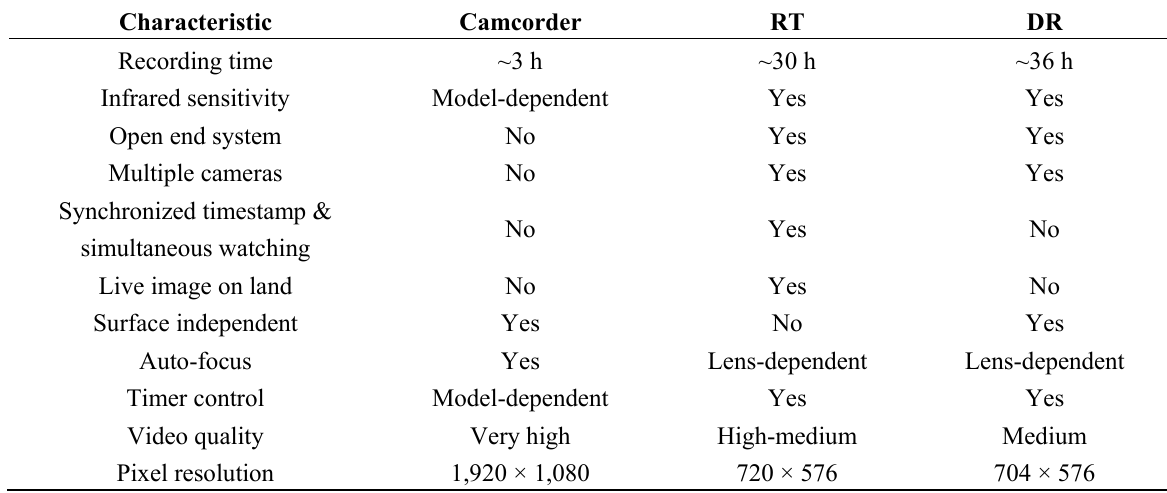
Table 1. Overview of the main characteristics and differences between a standard high-definition camcorder and the two reef surveillance systems for radio-transmission (RT) and direct-recording